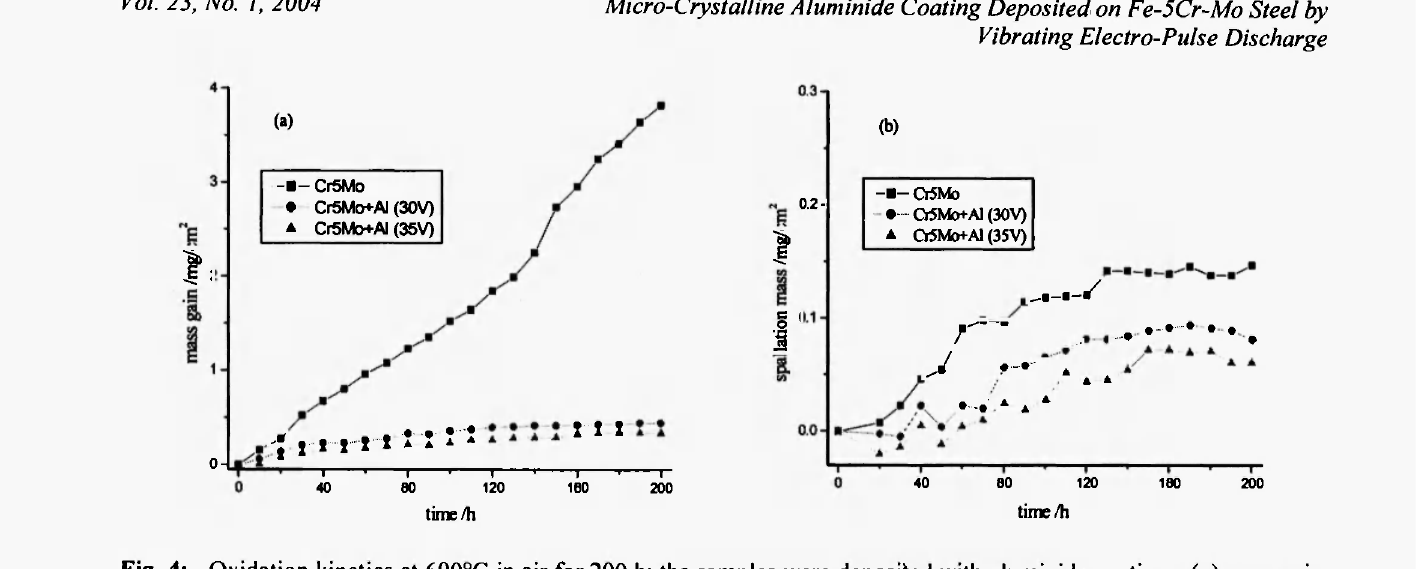
Fig. 4: Oxidation kinetics at 600°C in air for 200 h; the samples were deposited with aluminide coatings: (a) mass gain vs time, and (b) oxide spallation v.s time.